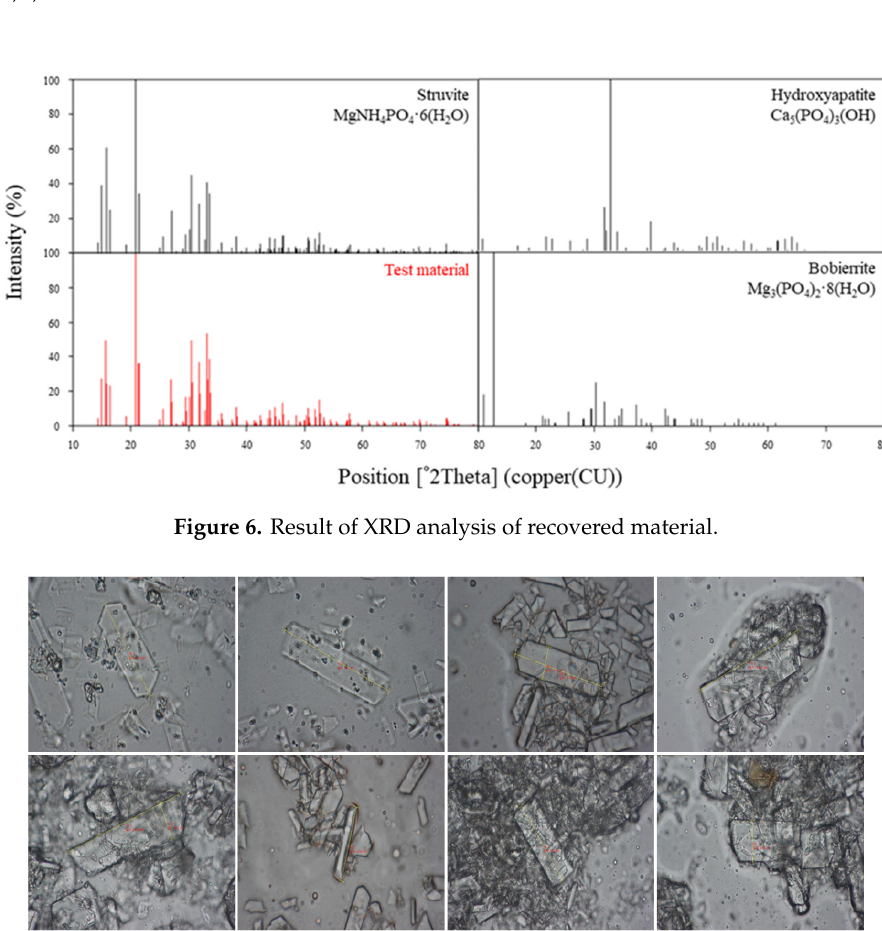
Table 6. Characteristics of recovered material from swine wastewater and the Korean standard limits of raw materials for fertilizer and feedstock .